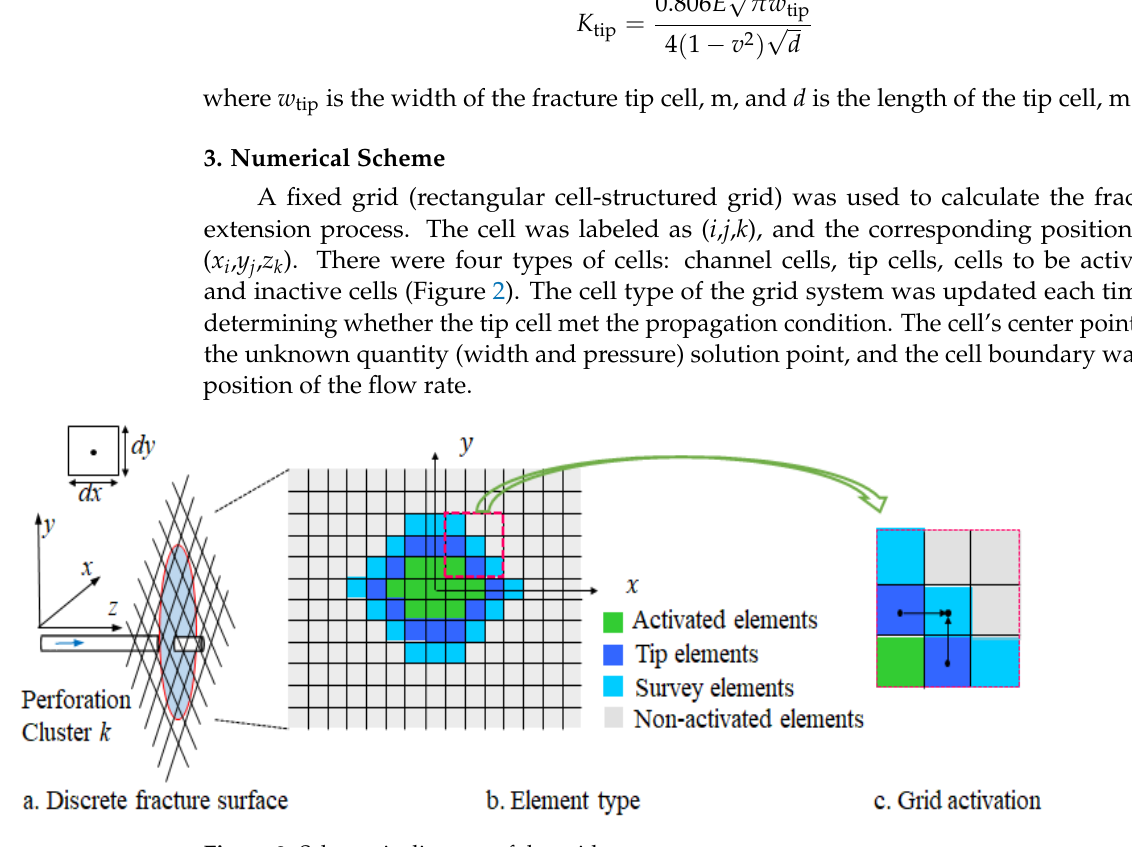
Figure 2. Schematic diagram of the grid.